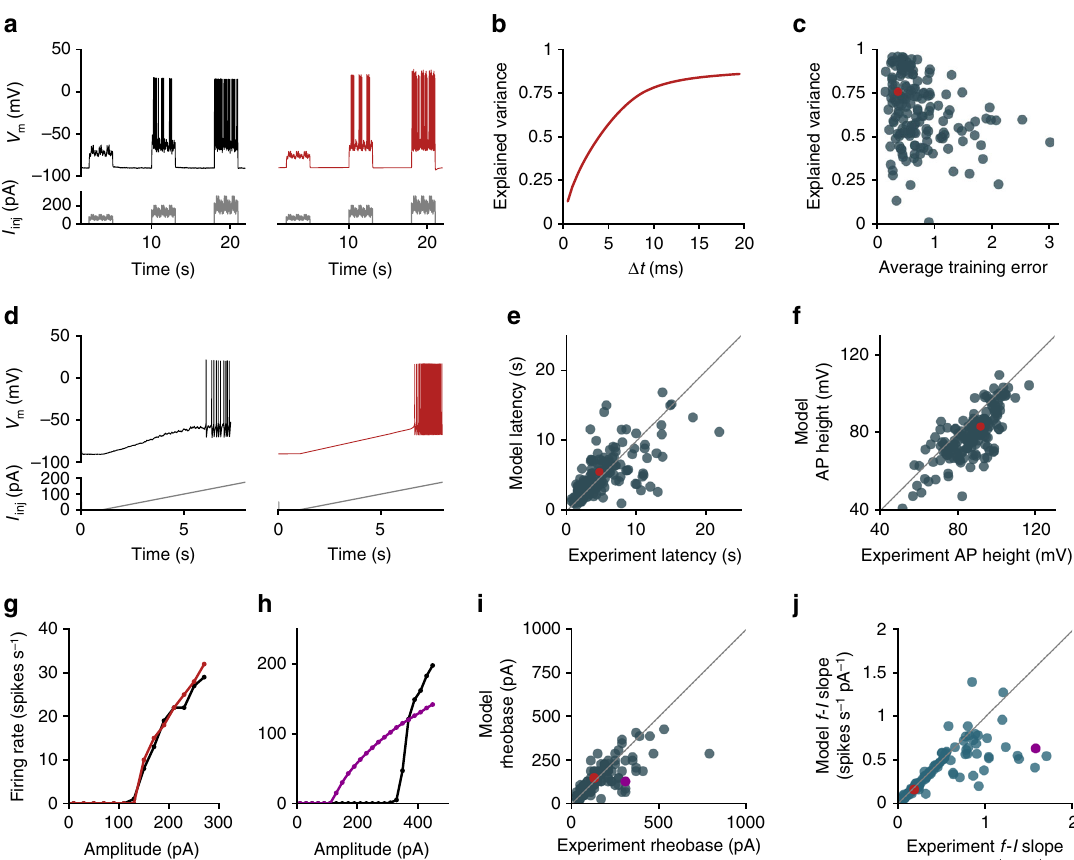
Fig. 6 Model generalization. a Responses to noisy current injection from the experimental data (black, left) and model (red, right). One experimental example from several repeated presentations of the stimulus is shown. b Explained variance of spike times as a function of the time window ( Δ t ) resolution for the cell in a . c Comparison between the explained variance with a time window Δ t = 10 ms and the average training error. d Responses to a slow ramp current injection (25 pA s − 1 ) from the experimental data (black, left) and model (red, right). One experimental example from several repeated presentations of the stimulus is shown. e Comparison between the latency to fi rst spike during the ramp stimulus for the model and experimental data. f Comparison between the height of the fi rst action potential during the ramp stimulus for the model and experimental data. g Average fi ring rates evoked by a range of current steps in the experiment (black) and by the model (red) for an example cell. Data from a , b , d , and g are from the same pyramidal ( Nr5a1 - labeled) cell, also indicated by red dots in c , e , and f . h Average fi ring rates evoked by a range of current steps in the experiment (black) and by the model (purple) for a fast-spiking ( Pvalb -labeled) interneuron. i Comparison of rheobases for the model and experimental data assessed by current steps at 20 pA increments. j Comparison of slopes for the model and experimental data measured by linear fi t of the non-zero part of the f – I curve. Data from examples in g and h are shown as red and purple dots, respectively, in i ,